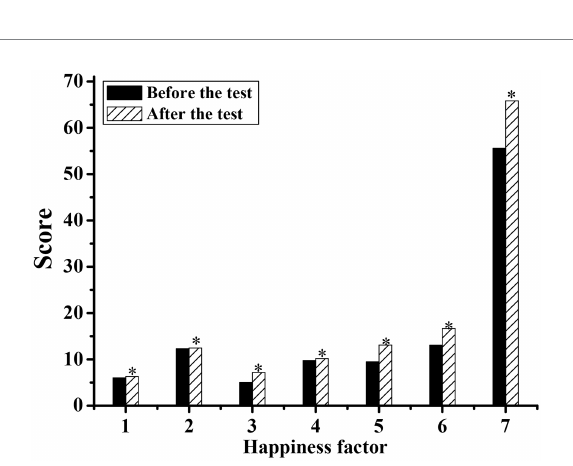
FIGURE 5 Comparison of the scores of the silver-haired happiness scale in the experimental group before and after the experiment. (1: worry about health; 2: energy; 3: satisfaction and interest in life; 4: depressed or happy mood; 5: control of emotion and behavior; 6: anxiety; 7: total score; * suggests there is a significant difference compared to before the test, p < 0.05).